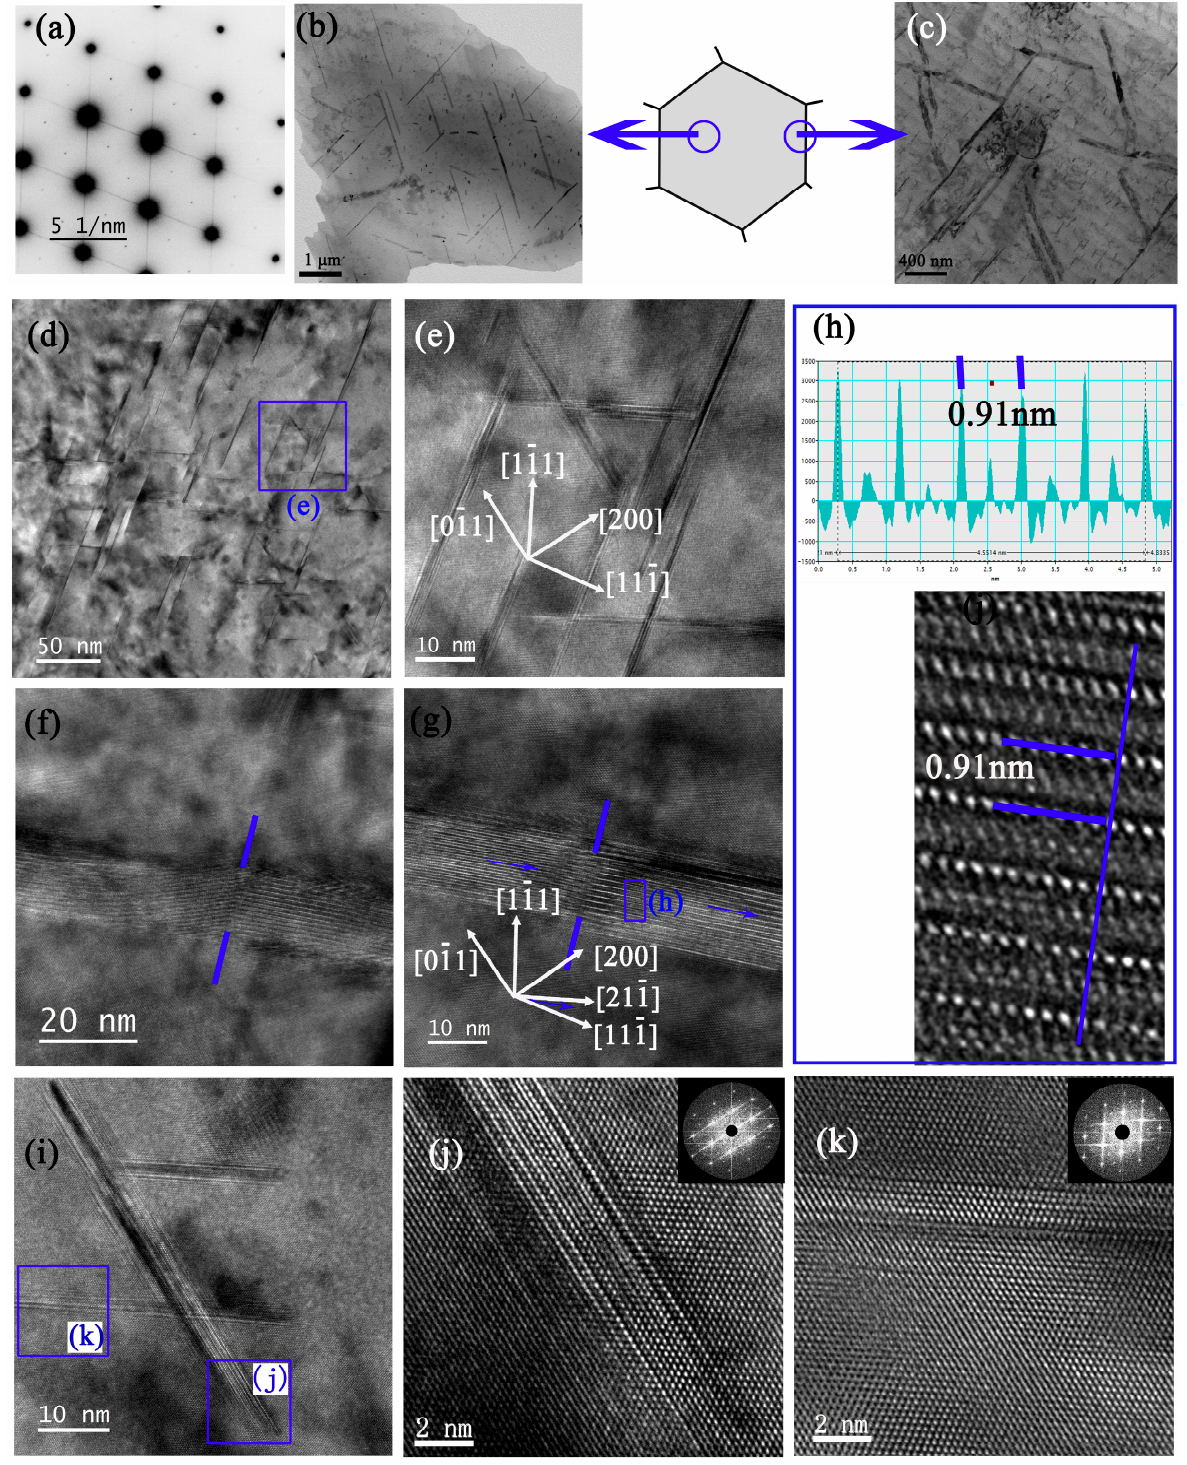
Figure 10. TEM analysis of 6# after 12 h creep. ( a ) SADP under [110] α . The BF of initial T 1 phases within the grain ( b ) and near the grain boundary ( c ). ( d , e ): the arrangement of secondary T 1 phase. ( f – h ): initial T 1 phase. ( i ) Enlarged BF of T 1 and θ (cid:48) phases, with corresponding HRTEMs of θ (cid:48) laid on (100) α plane ( j ) and T 1 on (111) α plane ( k ),